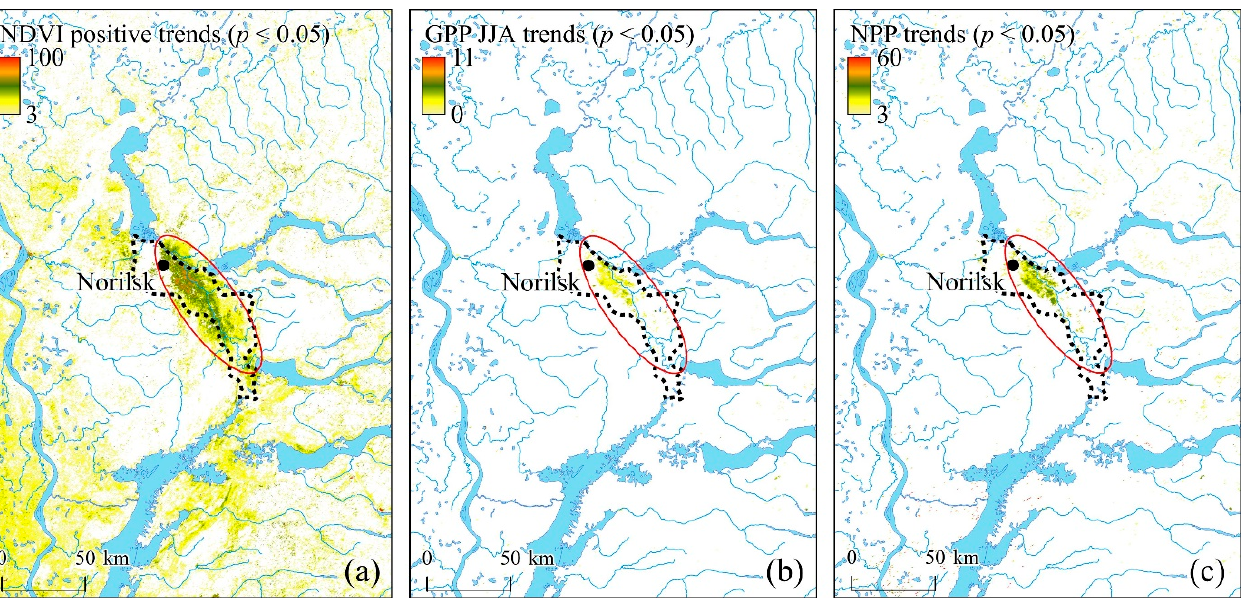
Figure 12. NDVI (10 − 4 /year), GPP (kg/ha/year), and NPP (kg/ha/year) significant ( p < 0.05) trends (2001–2021). The zone of significant productivity trends is shown by the oval. The dotted line approximated the area of the larch communities’ decline and mortality (adopted from [34]).